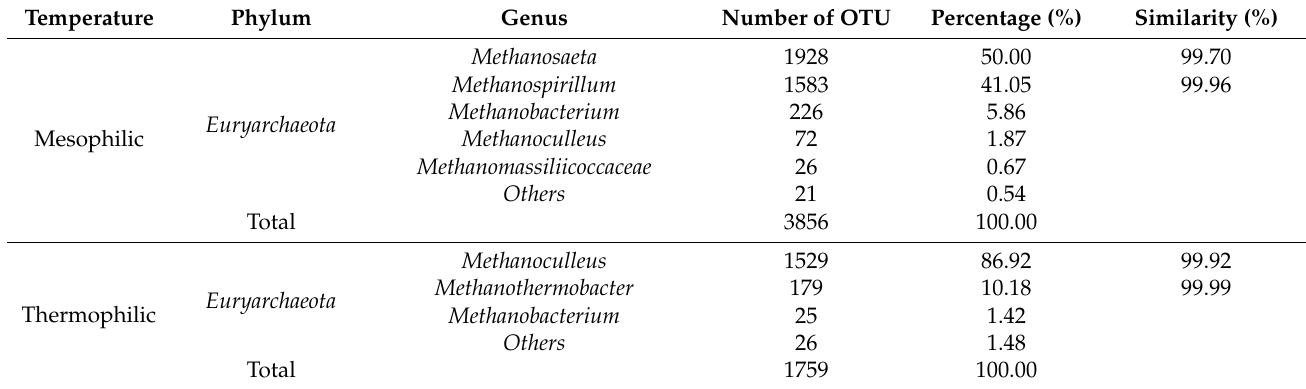
Table 2. Primary archaea composition in mesophilic and thermophilic